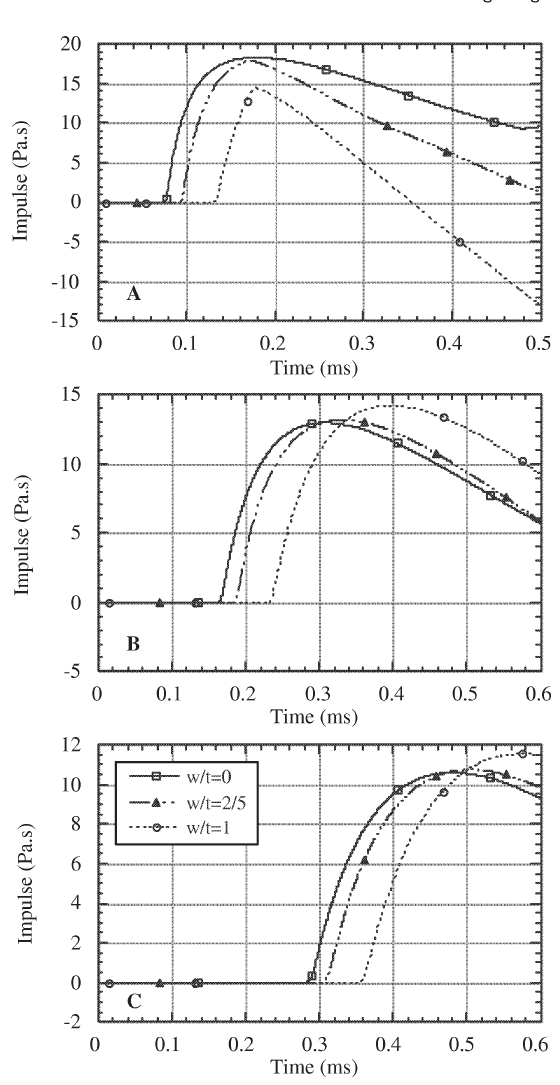
Fig. 8. Impulses calculated at A, B, and C, w=t = 0, w=t = 2 w=t = 1.